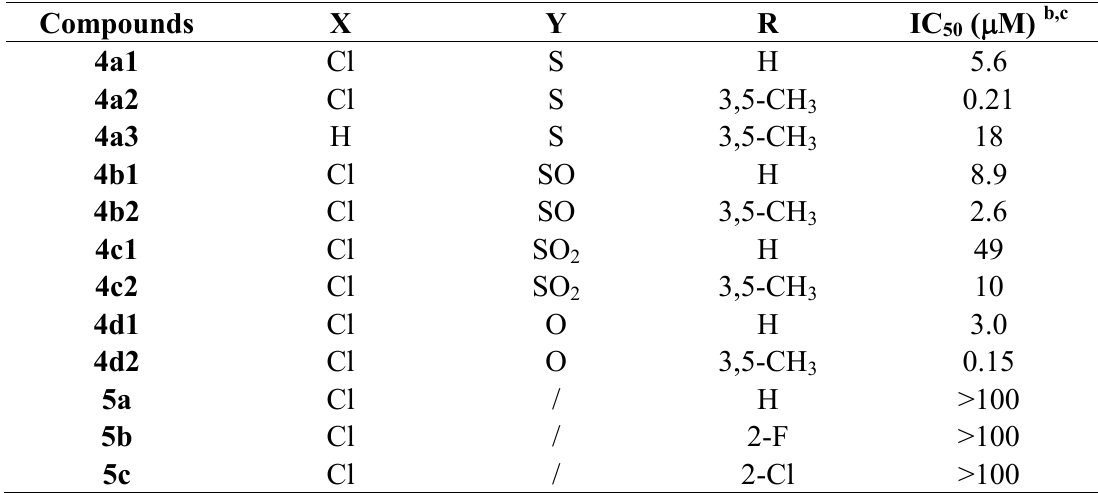
Table 1. HIV-1 RT inhibitory activities of compounds 4–5.